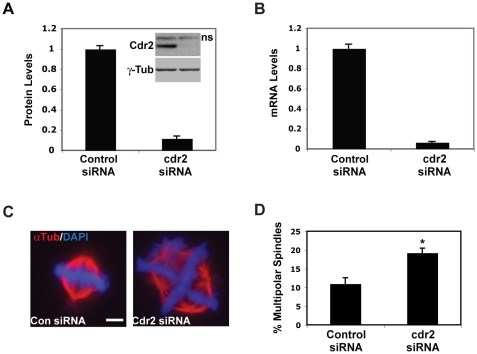
Multipolar spindle defects in cdr2 knockdown cells.A. Quantitation of cdr2 protein normalized to γ-tubulin in HeLa extracts transfected with control or cdr2 siRNAs probed with anti-cdr2 (4F5) and anti-γ-tubulin (inset). B. qRT-PCR of cdr2 mRNA normalized to β-actin mRNA in control or cdr2 siRNA treated cells. C. Immunostain of mitotic control (left) and cdr2 knockdown (right) HeLa cells with α-tubulin antisera and DAPI; Scale bar = 20 µm. D. Quantitation of multipolar spindles in control and cdr2 knockdown cells.